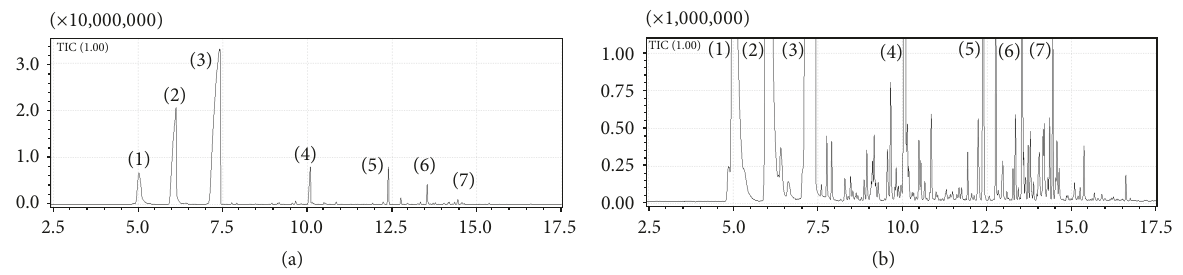
Figure 1: A chromatogram of the VOCs following a 40-minute extraction at 50 ∘ C: (a) depicts the chromatogram standardised against the largest peak (at about 7.5 min) expanded to cover the region between 2.5 and 17.5 minutes while (b) depicts 10 times magnified chromatogram showing several tens of peaks that are not visible in (a) due to their low relative abundances compared to the seven peaks visible in (a).